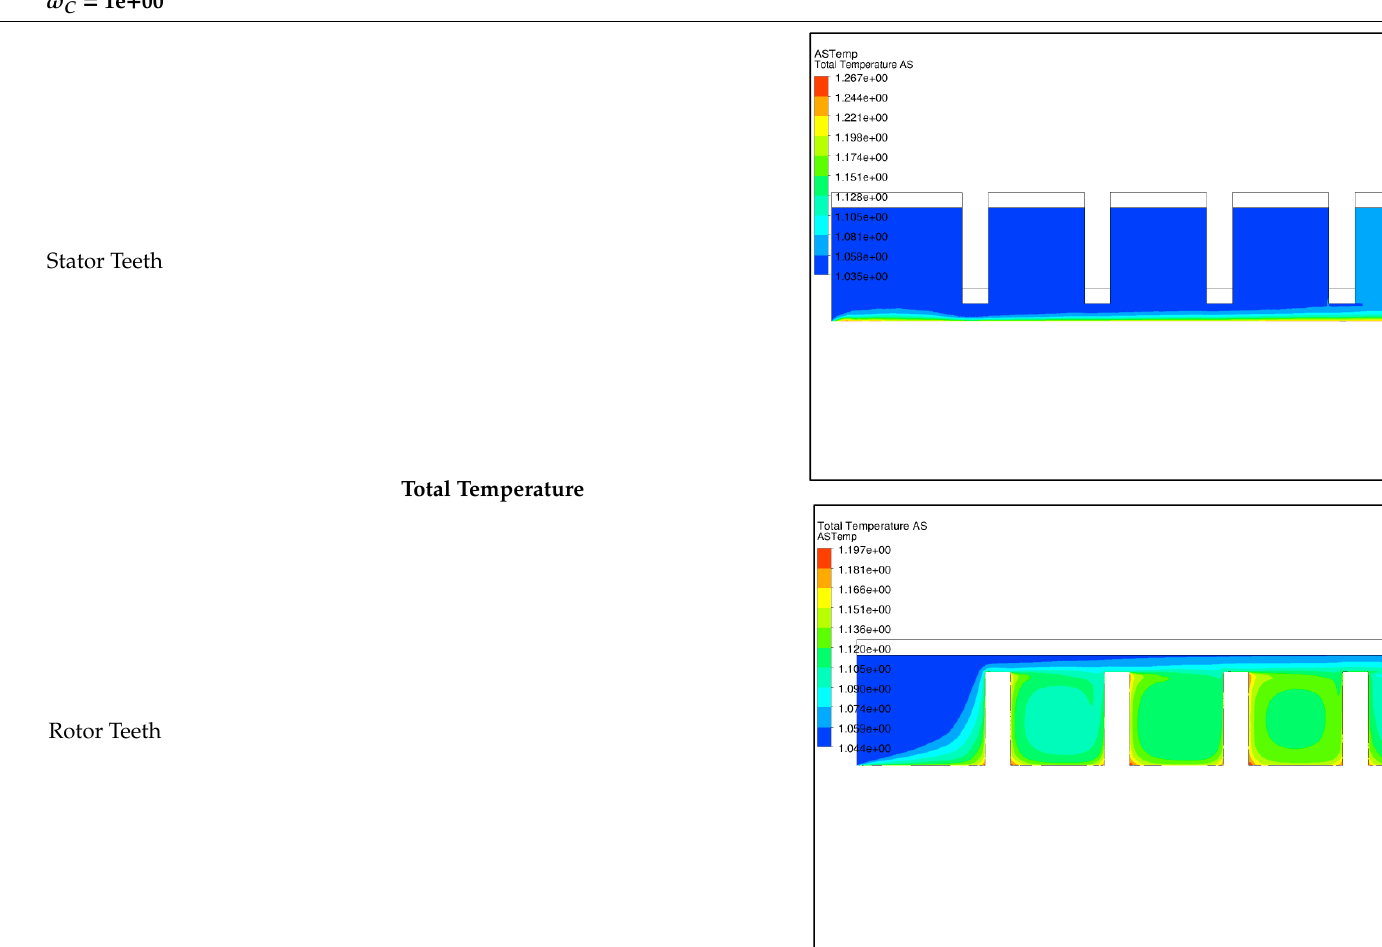
Table A1. Total Temperature Fields.